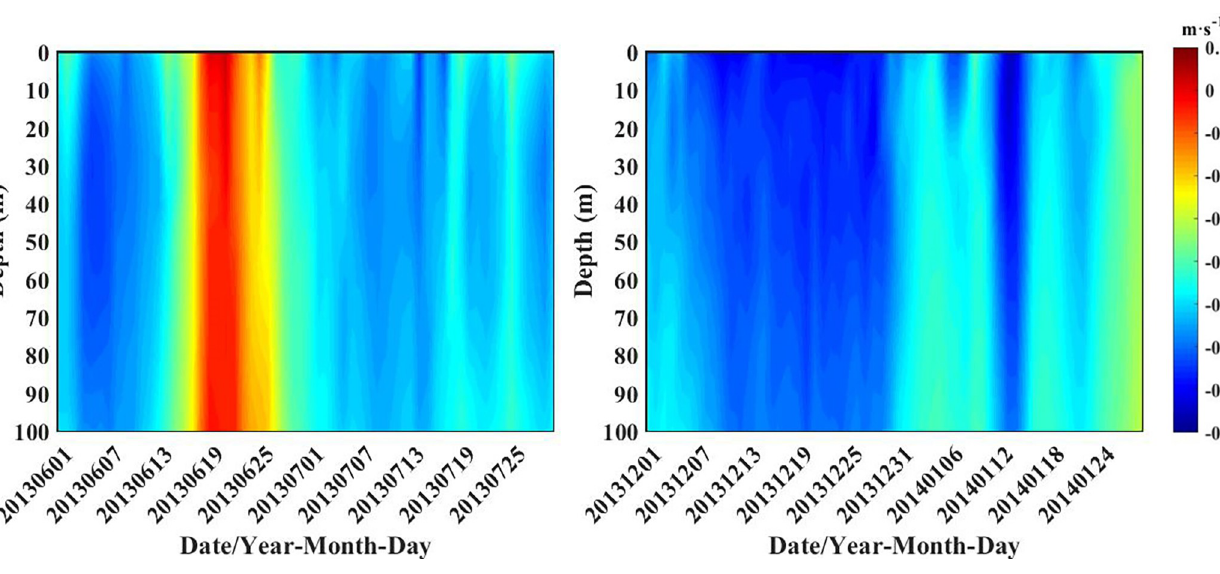
PLOS ONE | https://doi.org/10.1371/journal.pone.0281766 March 27,